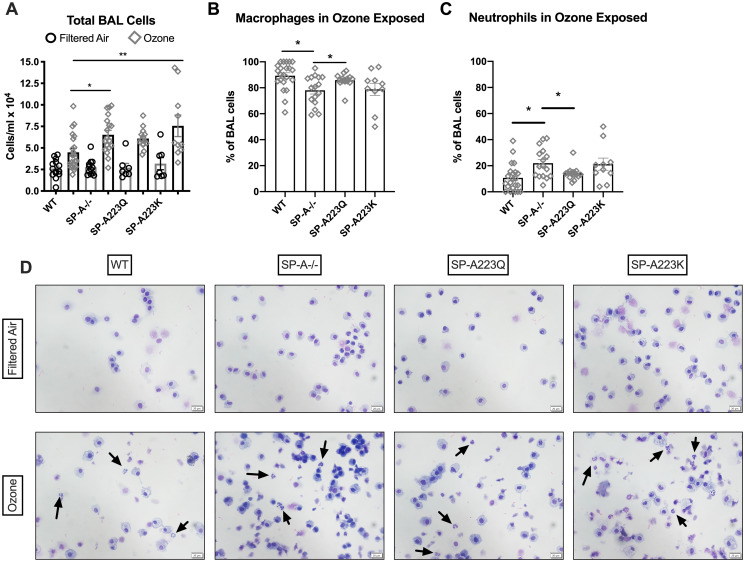
Genetic differences in SP-A2 on the cellular response to ozone at 23 hrs.After pulmonary function assessment, the lungs were gently lavaged and cellularity was determined. (A) Total cells were counted with Trypan blue exclusion for dead cells. The percentage of (B) macrophages and (C) neutrophils were determined 24 hrs post ozone challenge by differential cell counts. FA controls had ~98% macrophages (not shown). *p<0.05, **p<0.01. (D) Representative pictures of differentials take at 40X magnification, scale bar = 20 μm. Arrows indicate neutrophils.